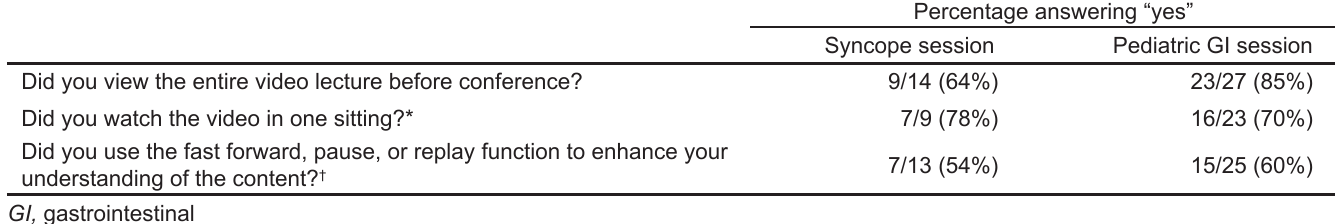
GI, gastrointestinal *Only responses from those who had watched the entire video are included. † All responses are included.